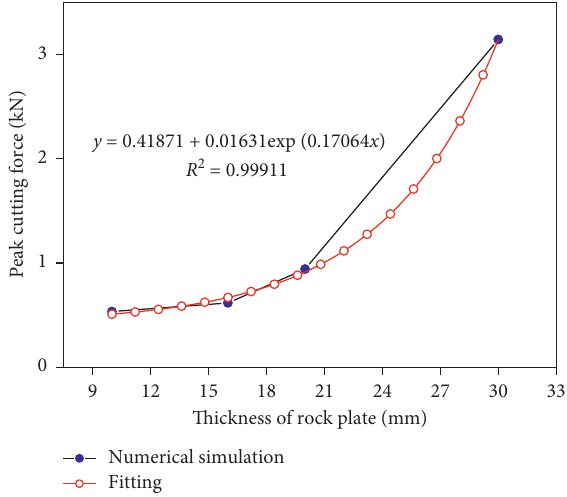
Figure 15: The relationship between PCF and thickness of rock plate. Table 5: Regression analysis results between thickness and PCF.